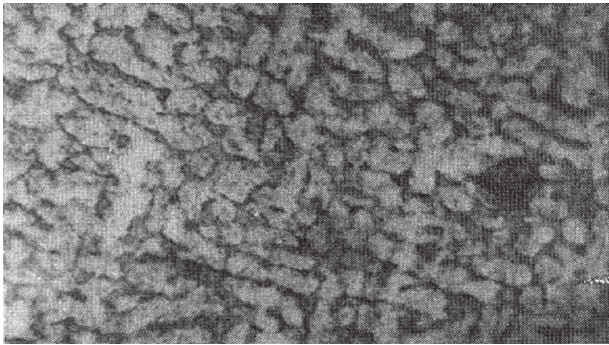
Figure 5. Micrograph of welded sample subjected to current I processing (×100).